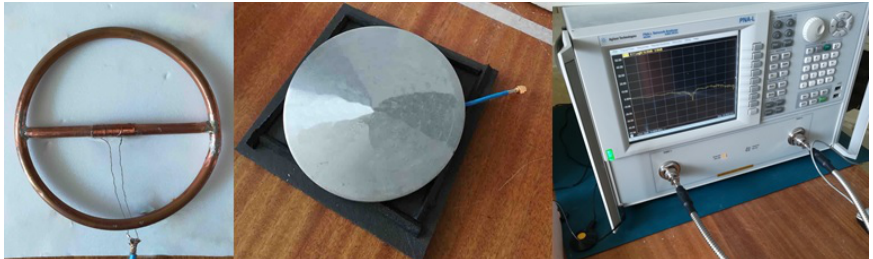
Figure 12. Microwave near-field copper tube probe and experimental setup for a unidirectional probe.